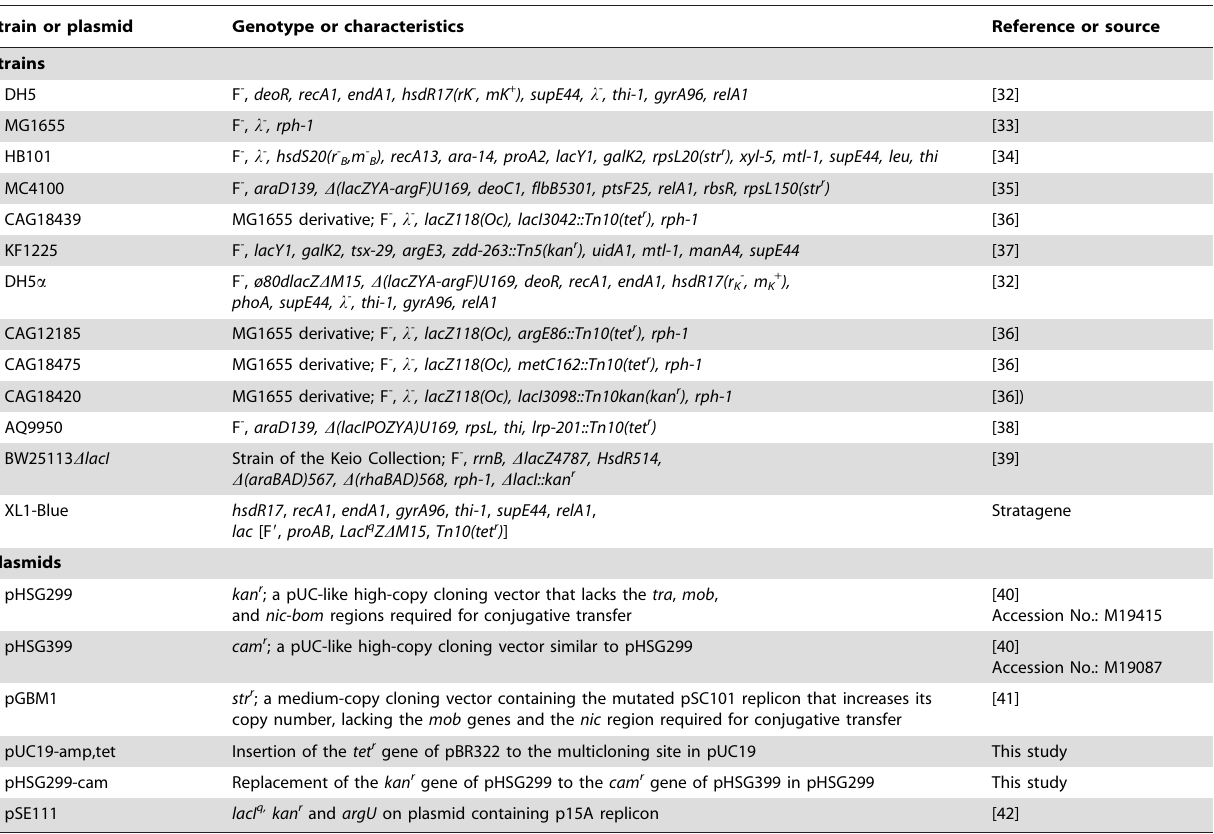
Table 1. E. coli strains and plasmids used in this